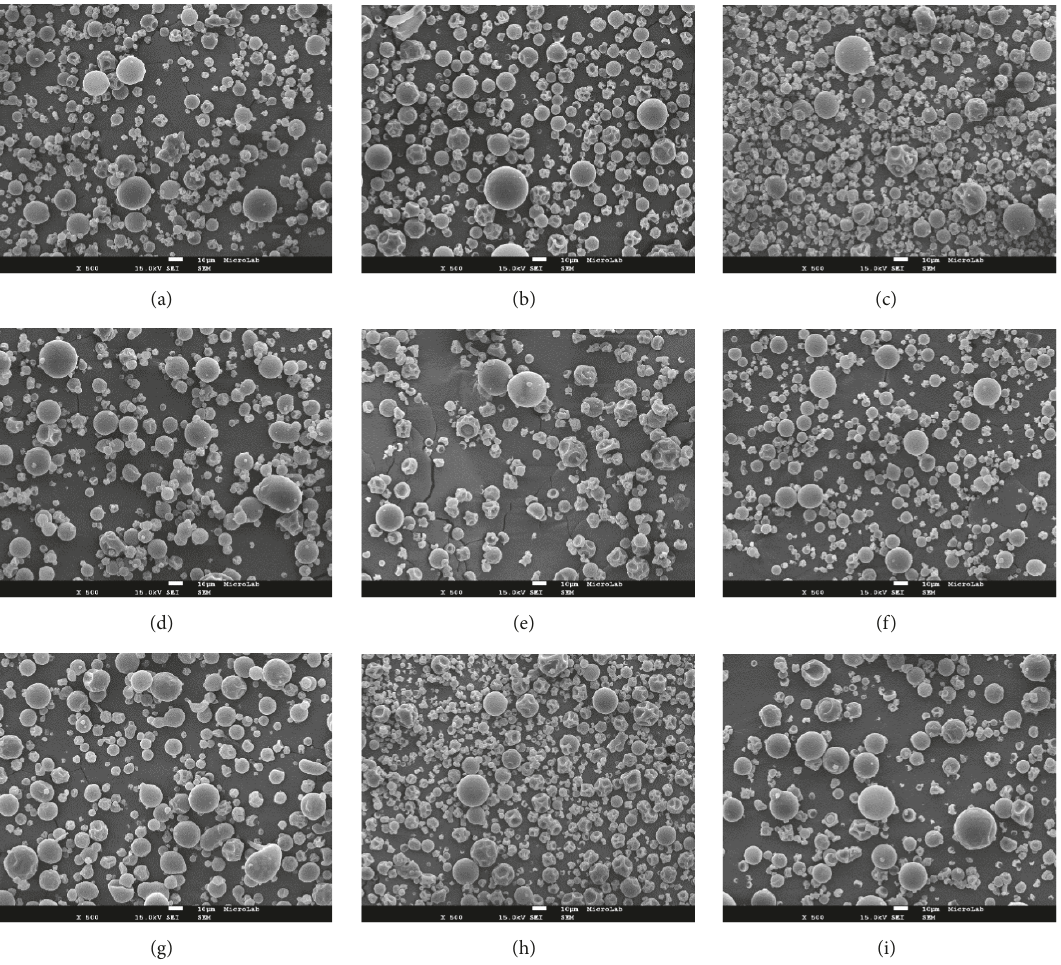
Figure 1: Scanning electron microscopy (SEM) images (magnification x500) of arabic gum microparticles with microencapsulated 𝛽 - carotene. (a) 9.4 %AG, 123.2 ∘ C; (b) 9.4 %AG, 186.8 ∘ C; (c) 30.6 %AG, 123.2 ∘ C; (d) 30.6 %AG, 186.8 ∘ C; (e) 20 %AG, 155 ∘ C; (f) 5 %AG, 155 ∘ C; (g) 35 %AG; 155 ∘ C; (h) 20 %AG, 110 ∘ C; (i) 20 %AG, 200 ∘